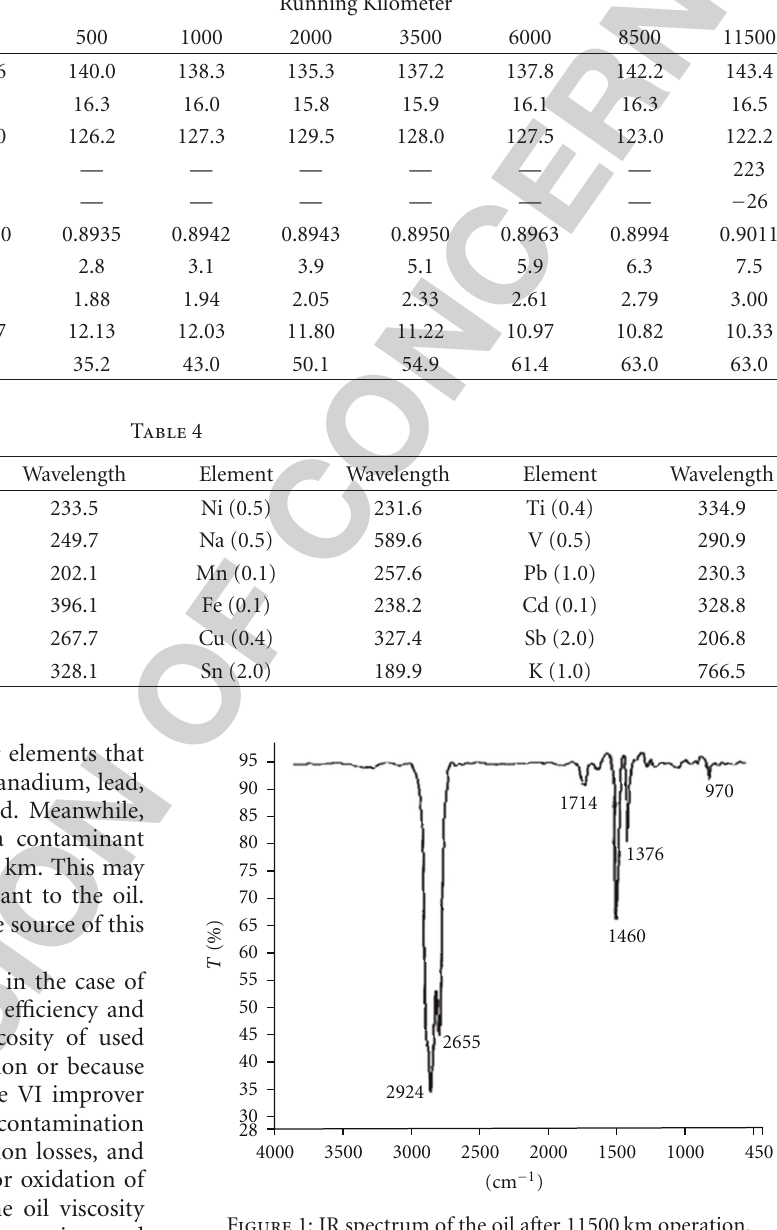
Figure 1: IR spectrum of the oil after 11500 km